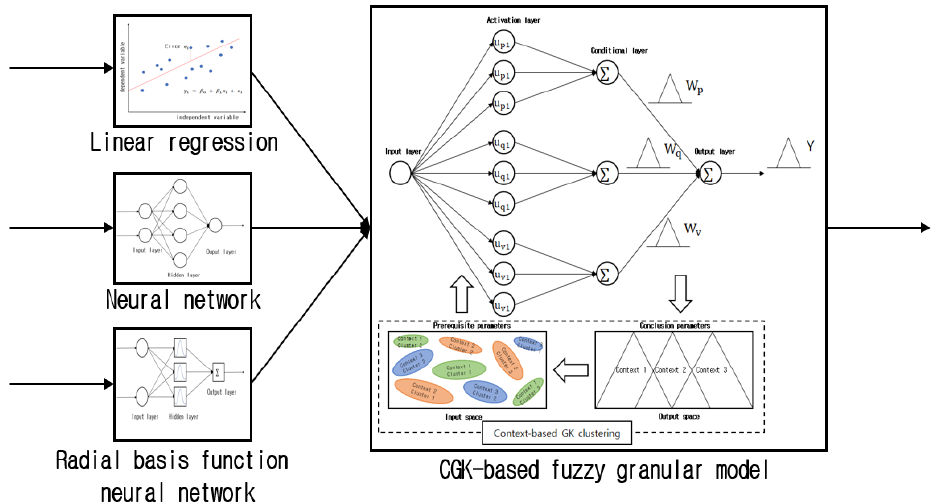
Figure 3. CGK-based fuzzy granular model of the aggregated structure.